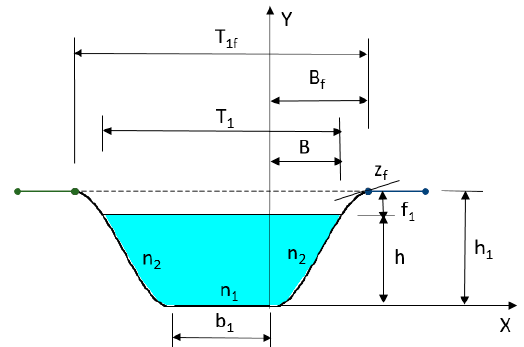
Figure 3. Simple polynomial section.